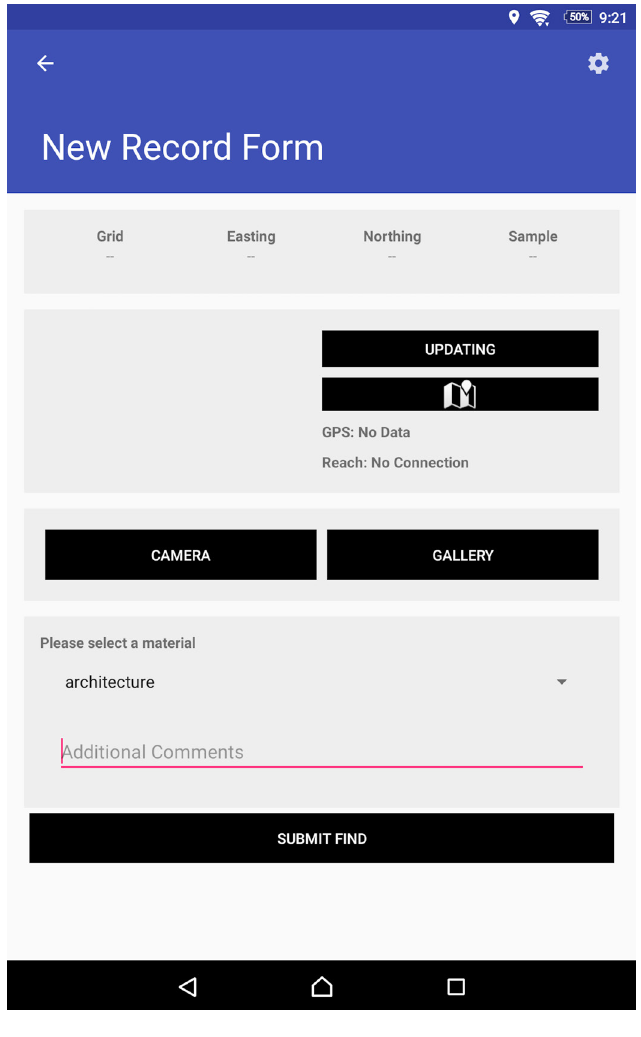
Figure 1. Screen capture of the location tracking app user